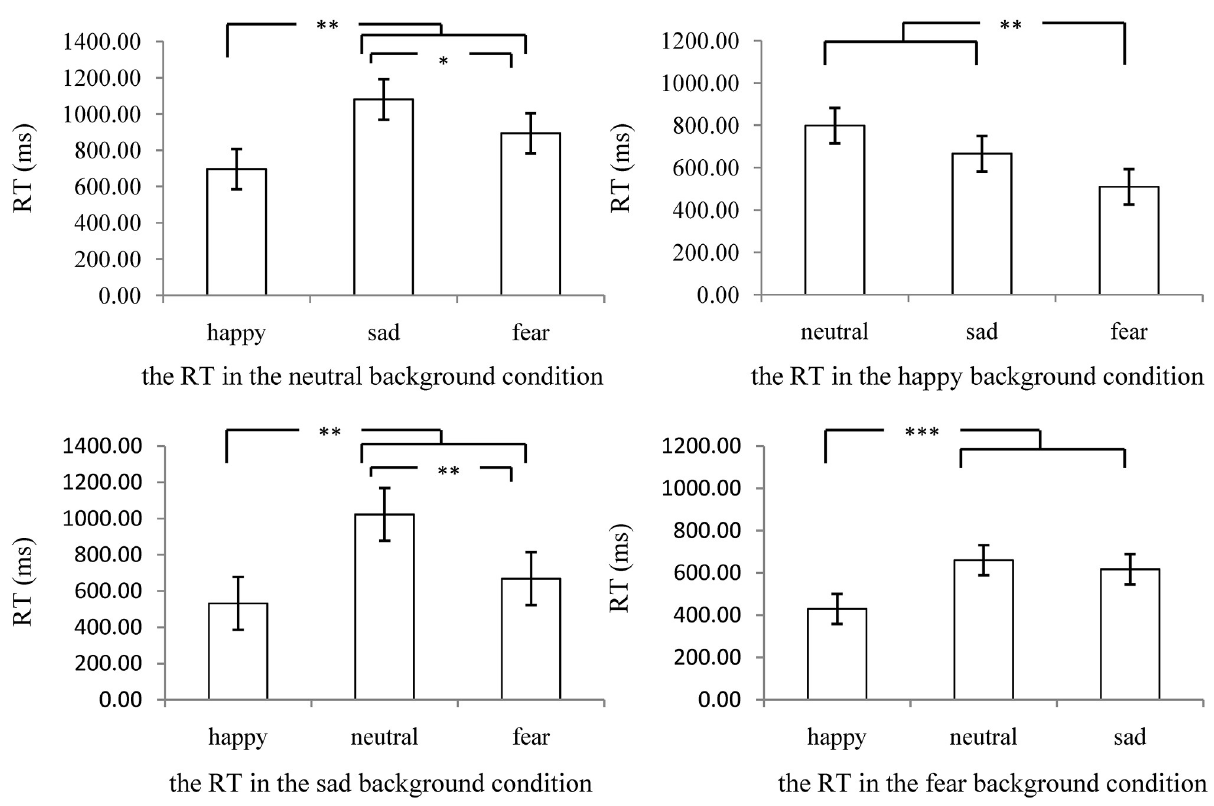
Fig 3. The RT of recognizing different MEs in different background conditions. “ � ”stands for “ p < 0.05”, “ �� ”stands for “ p < 0.01”, “ ��� ”stands for “ p < 0.001”. Error bar represents standard